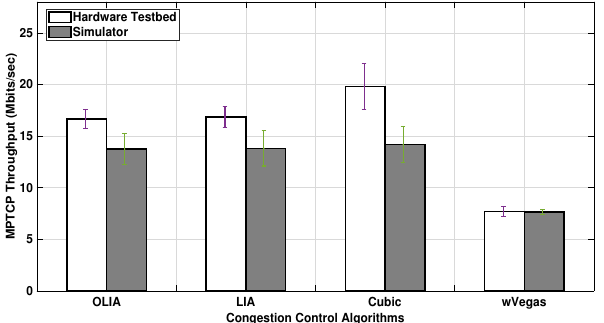
Figure 8. Setup 2 Uplink MPTCP Throughput for 75 MB